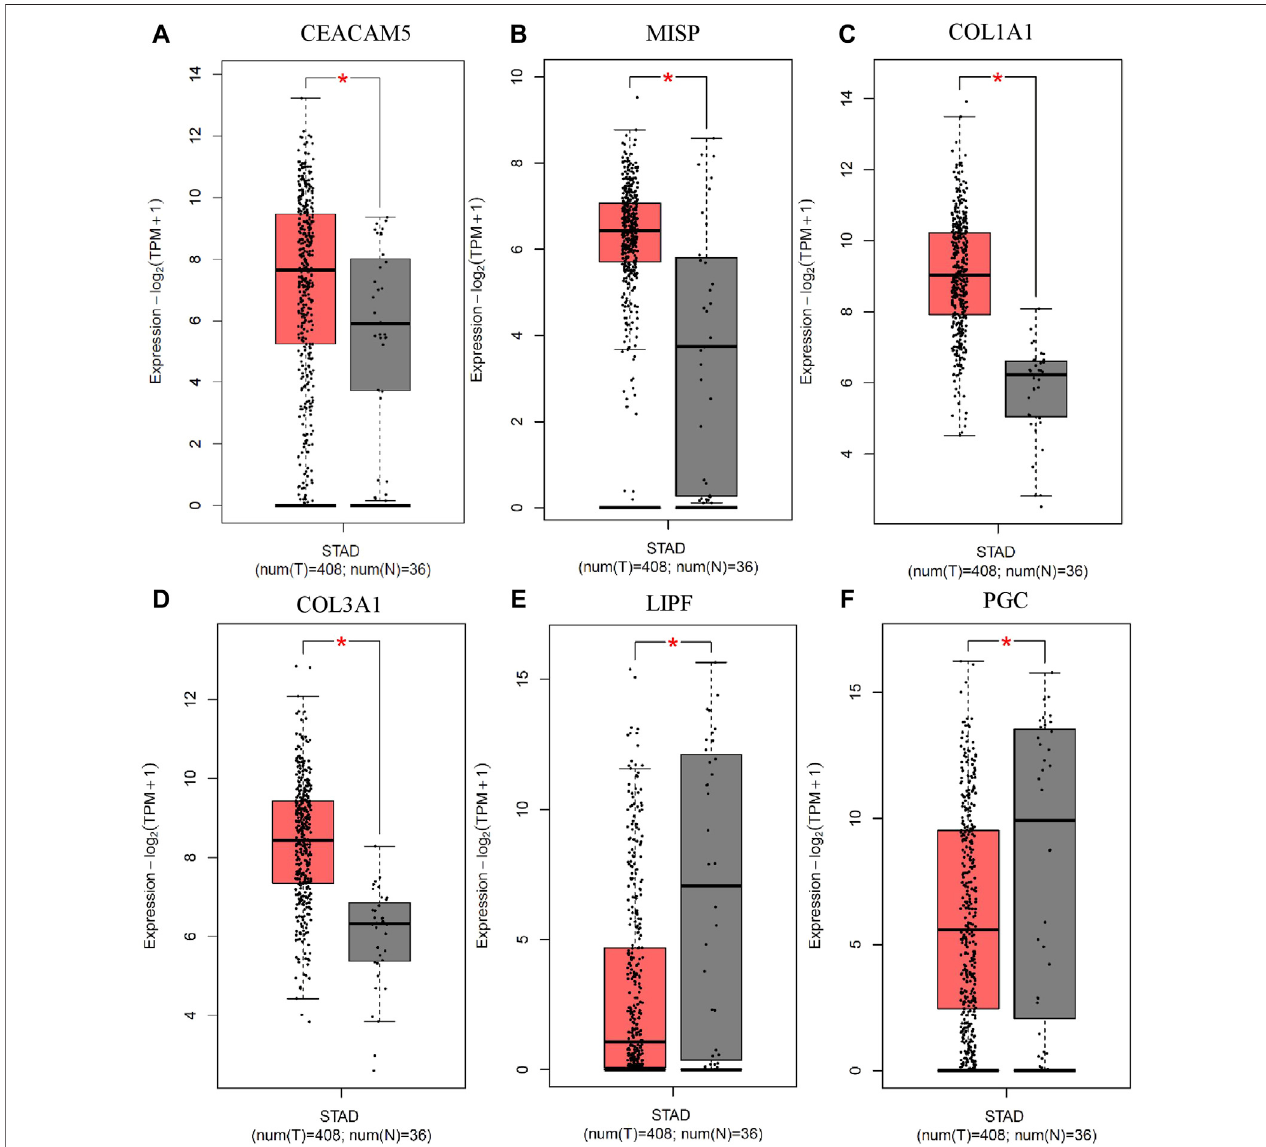
FIGURE 7 | Validation of the expression of 6 host genes of the top up and down regulated circRNAs in GC. The expression of (A) CEACAM5, (B) MISP, (C) COL1A1 and (D) COL3A1 was upregulated, and the expression of (E) LIPF and (F) PGC was downregulated in gastric tumor compared to normal samples from the TCGA data. The cutoffs |Log2FoldChange| > 1 and p -value < 0.05 were considered as statistically signi fi cant.